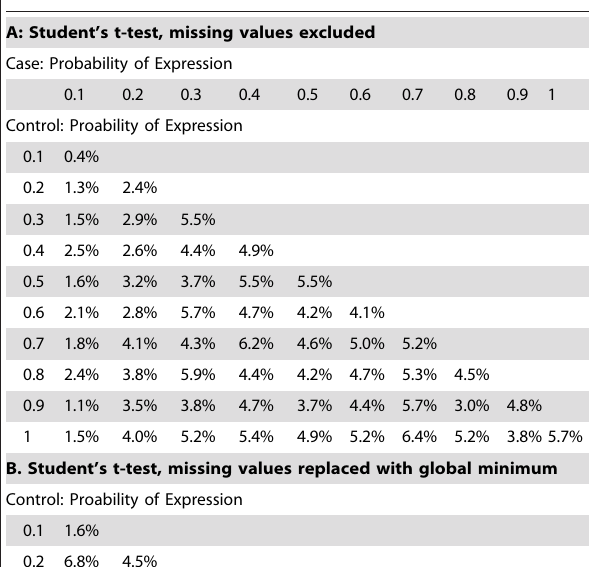
Difference between means (SD)*